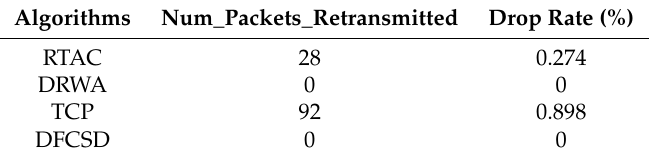
Figure 10. The obtained goodput of the network when a short flow competes with a long flow whose sizes are 128 KB and 10 MB, respectively. Table 1. The amount of data retransmitted of the network in Scenario_2 shown in Figure 6.